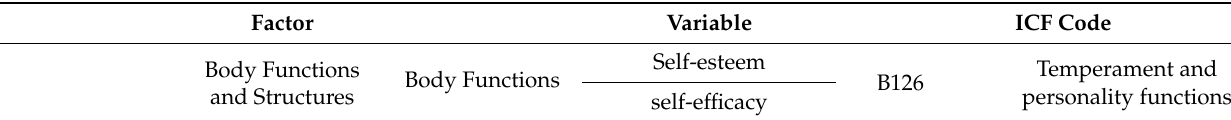
Table 1. The application of the ICF classification system according to